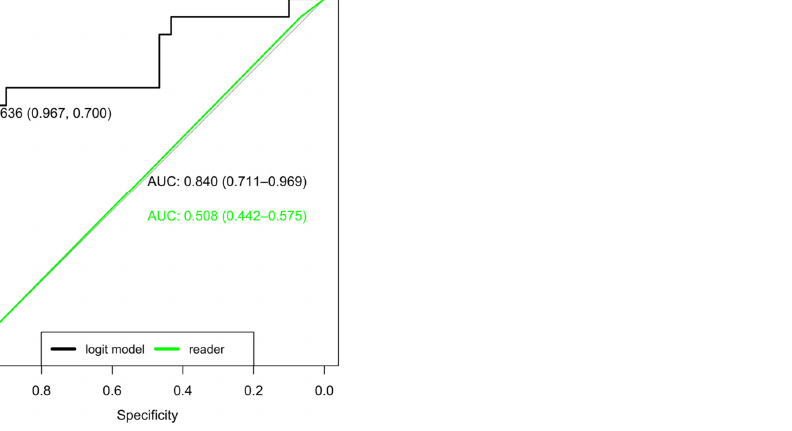
Figure 3. ROC curve (black) for the logistic regression model and ROC curve (green) for the radio- logical readers. ical